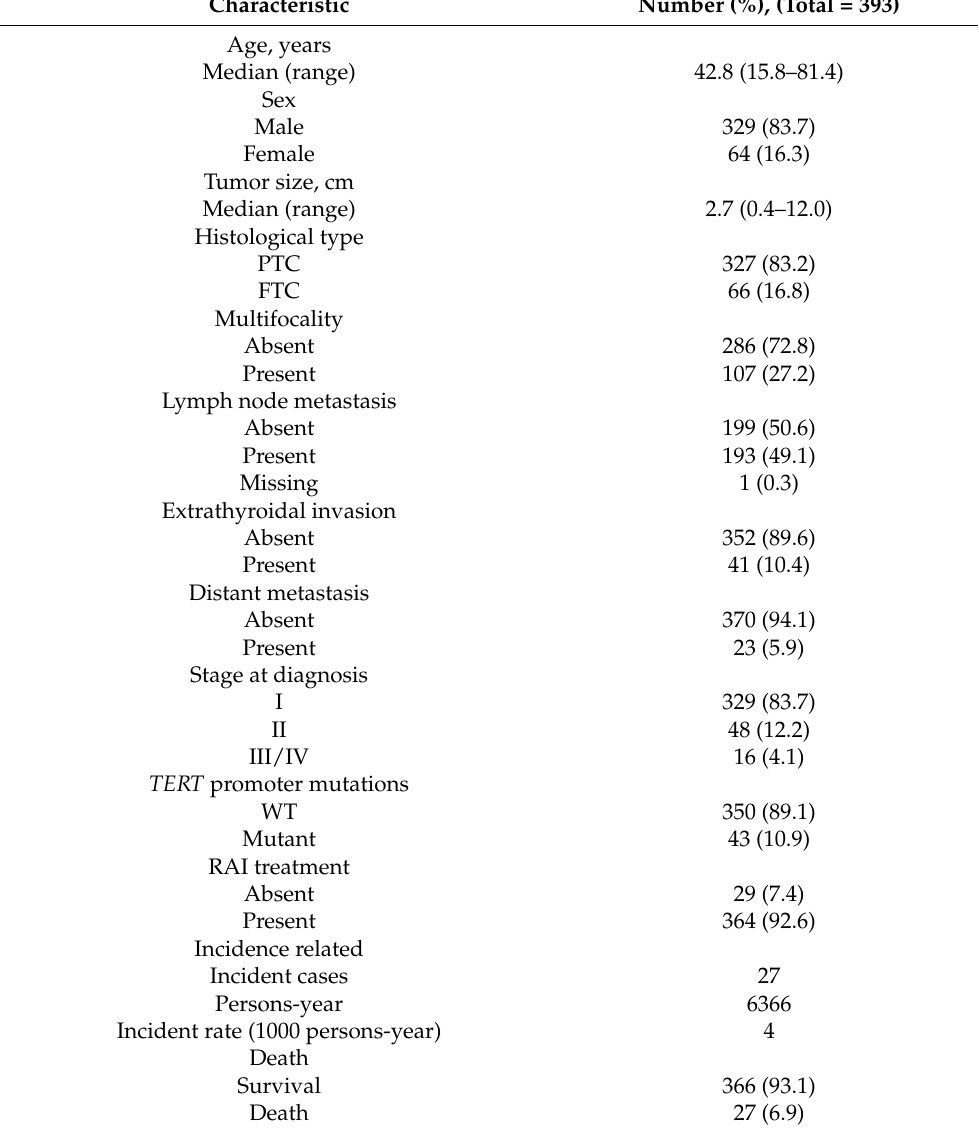
Table 1. Baseline characteristics of study